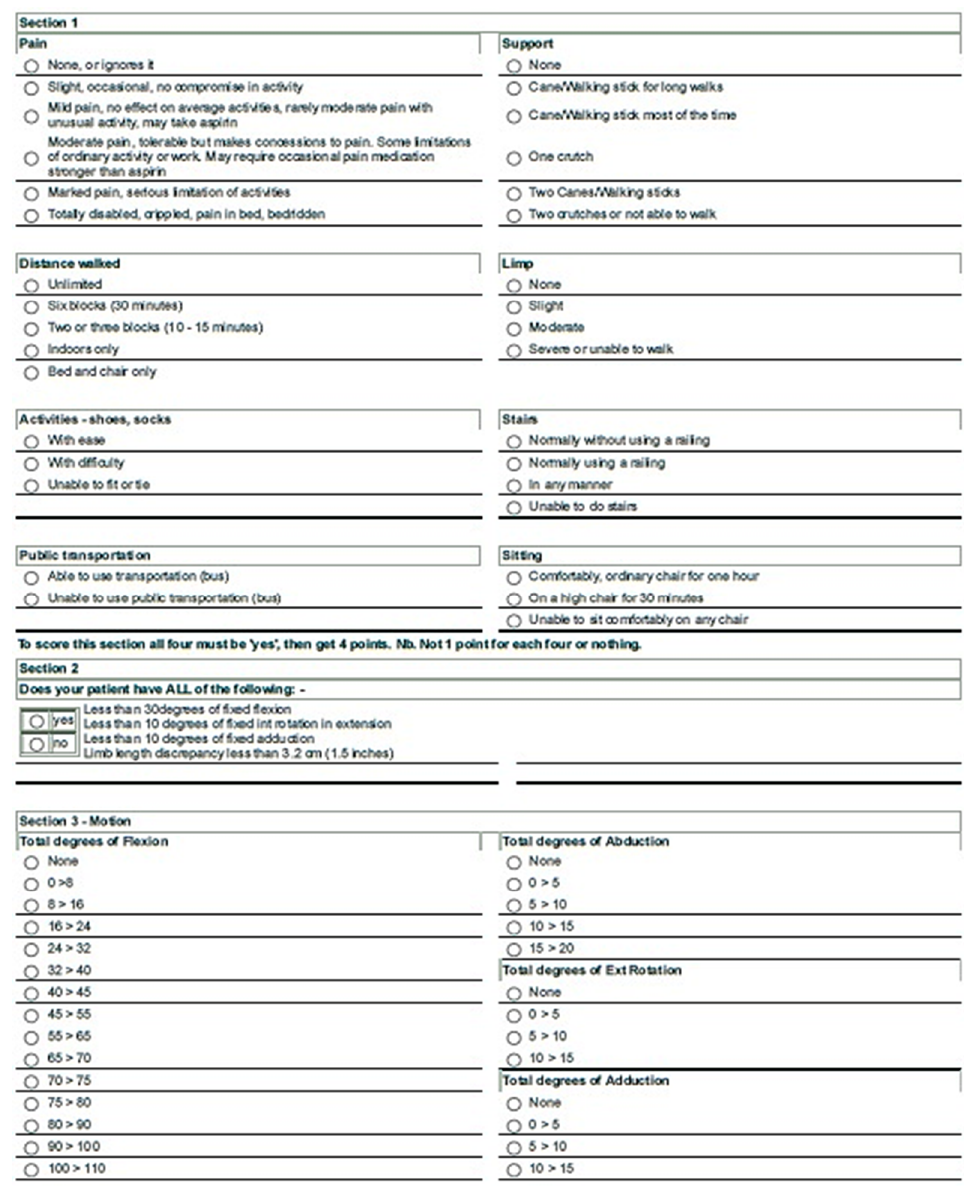
Figure 4. The scoring table for HHS, as it was administered in this study. Section 1 calculates a score based on pain and several functions, determined by lower-limb functionality, as reported by the patient. Section 2 is based on physician evaluation of hip range of movement and limb discrepancy. Section 3 is based on an accurate evaluation of any hip movement in the three dimensions.